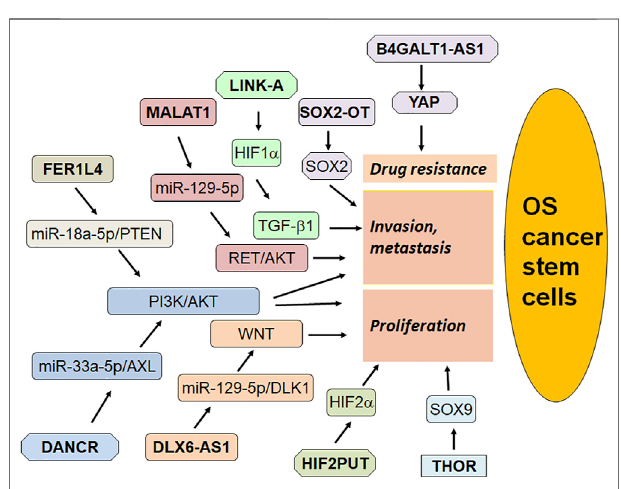
FIGURE 2 | The role of lncRNAs in regulation of OS stem cells.